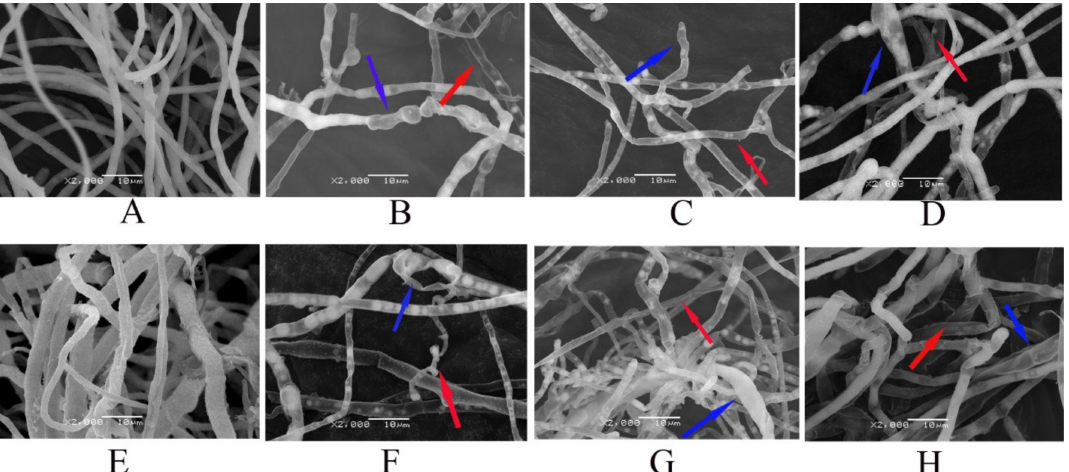
Figure 6. SEM images of the structural changes in the morphology of F. graminearum induced by fungicides, GO–fungicides and GO. Mycelia of the control ( A ), GO–treated ( E , 100 µ g/mL − 1 ), Man–treated ( B , 20 µ g mL − 1 ), Man–GO–treated ( F , 20 µ g mL − 1 ), Cyp–treated ( C , 100 µ g mL − 1 ), Cyp–GO–treated ( G , 100 µ g mL − 1 ), Dif–treated ( D , 200 µ g mL − 1 ) and Dif–GO–treated ( H , 200 µ g mL − 1 ) F. graminearum , respectively. The position marked by a red arrow indicates hollowness, and that marked by a blue arrow indicates